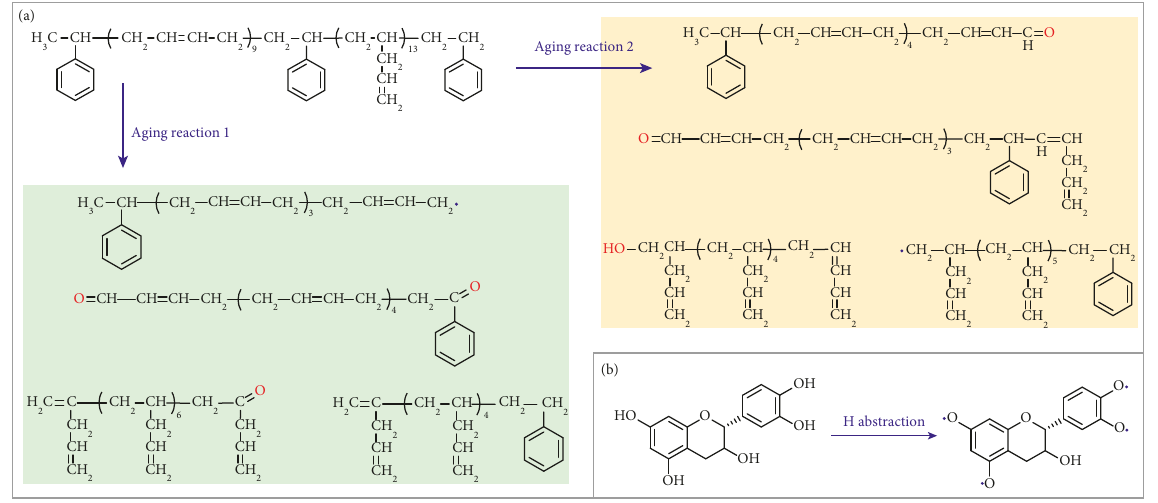
Figure 8: Changes in molecular structures of the rubber polymer and catechin during aging.